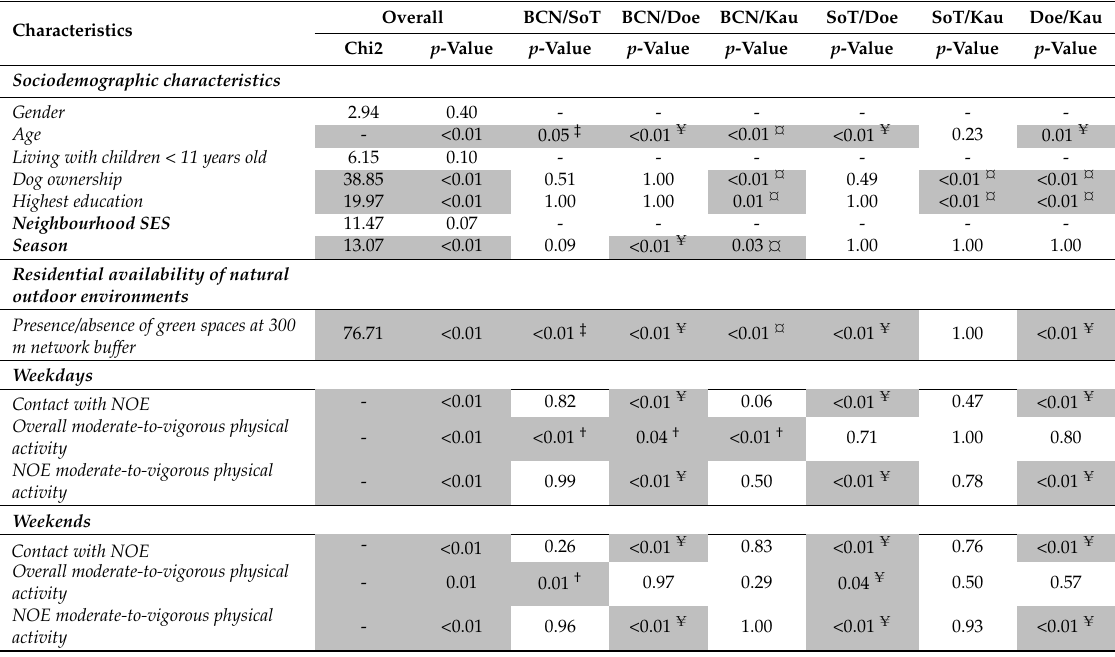
Table A2. Comparison of sample characteristics between the different cities. Results of Chi2, ANOVA, and posthoc Tukey, and Bonferroni tests.